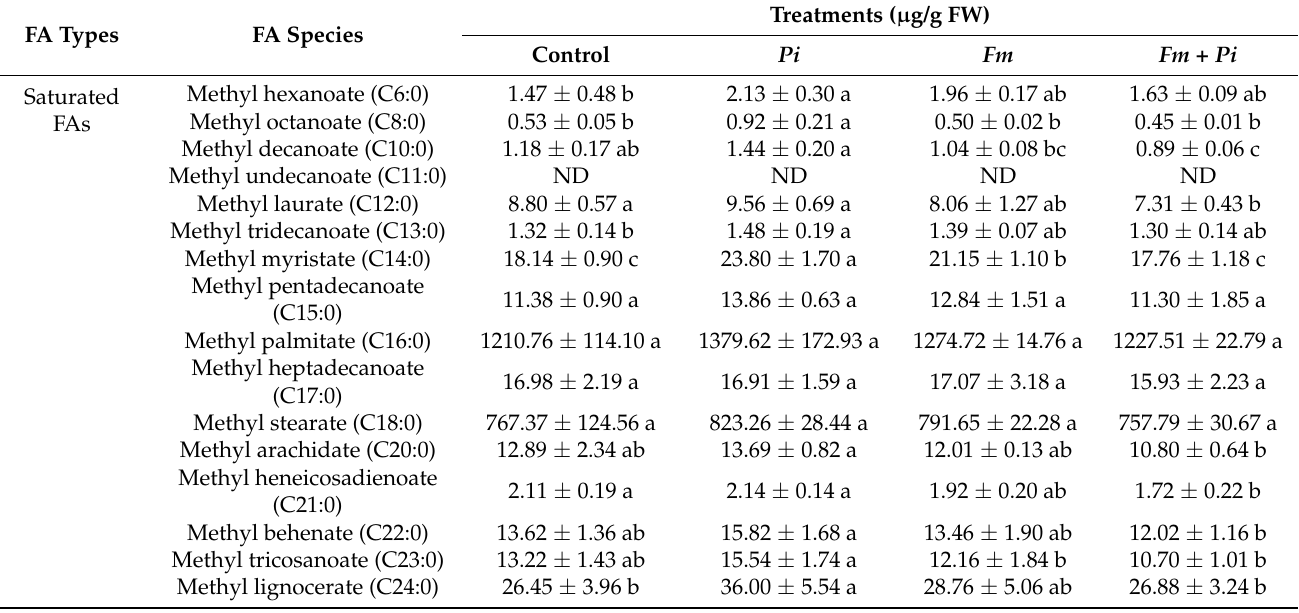
Table 3. Effects of Piriformospora indica ( Pi ) and Funneliformis mosseae ( Fm ) singly and in combination on the root fatty acid composition of trifoliate orange